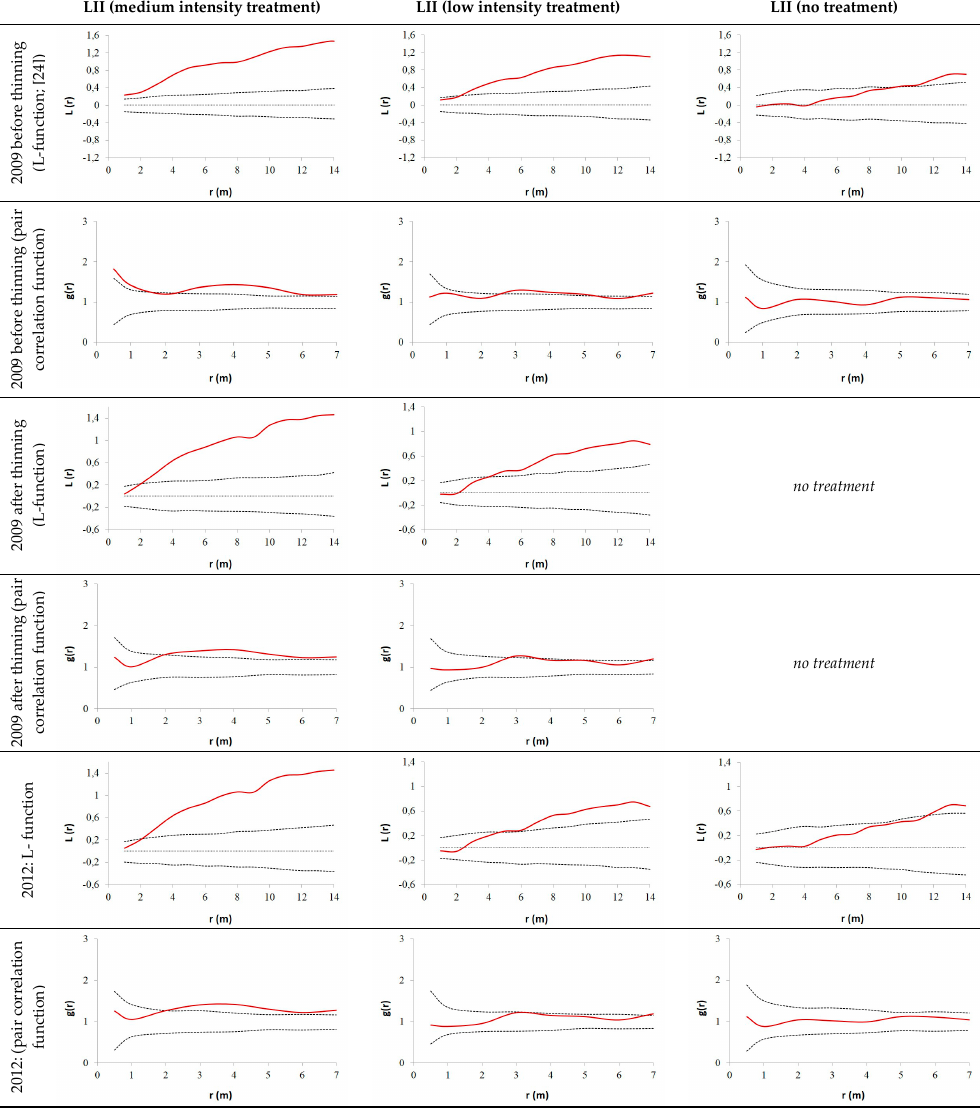
Figure 6. L-function and pair correlation function of the plots in stand LII before and after thinning in 2009 and at the end of the observation period. 2009 and at the end of the observation